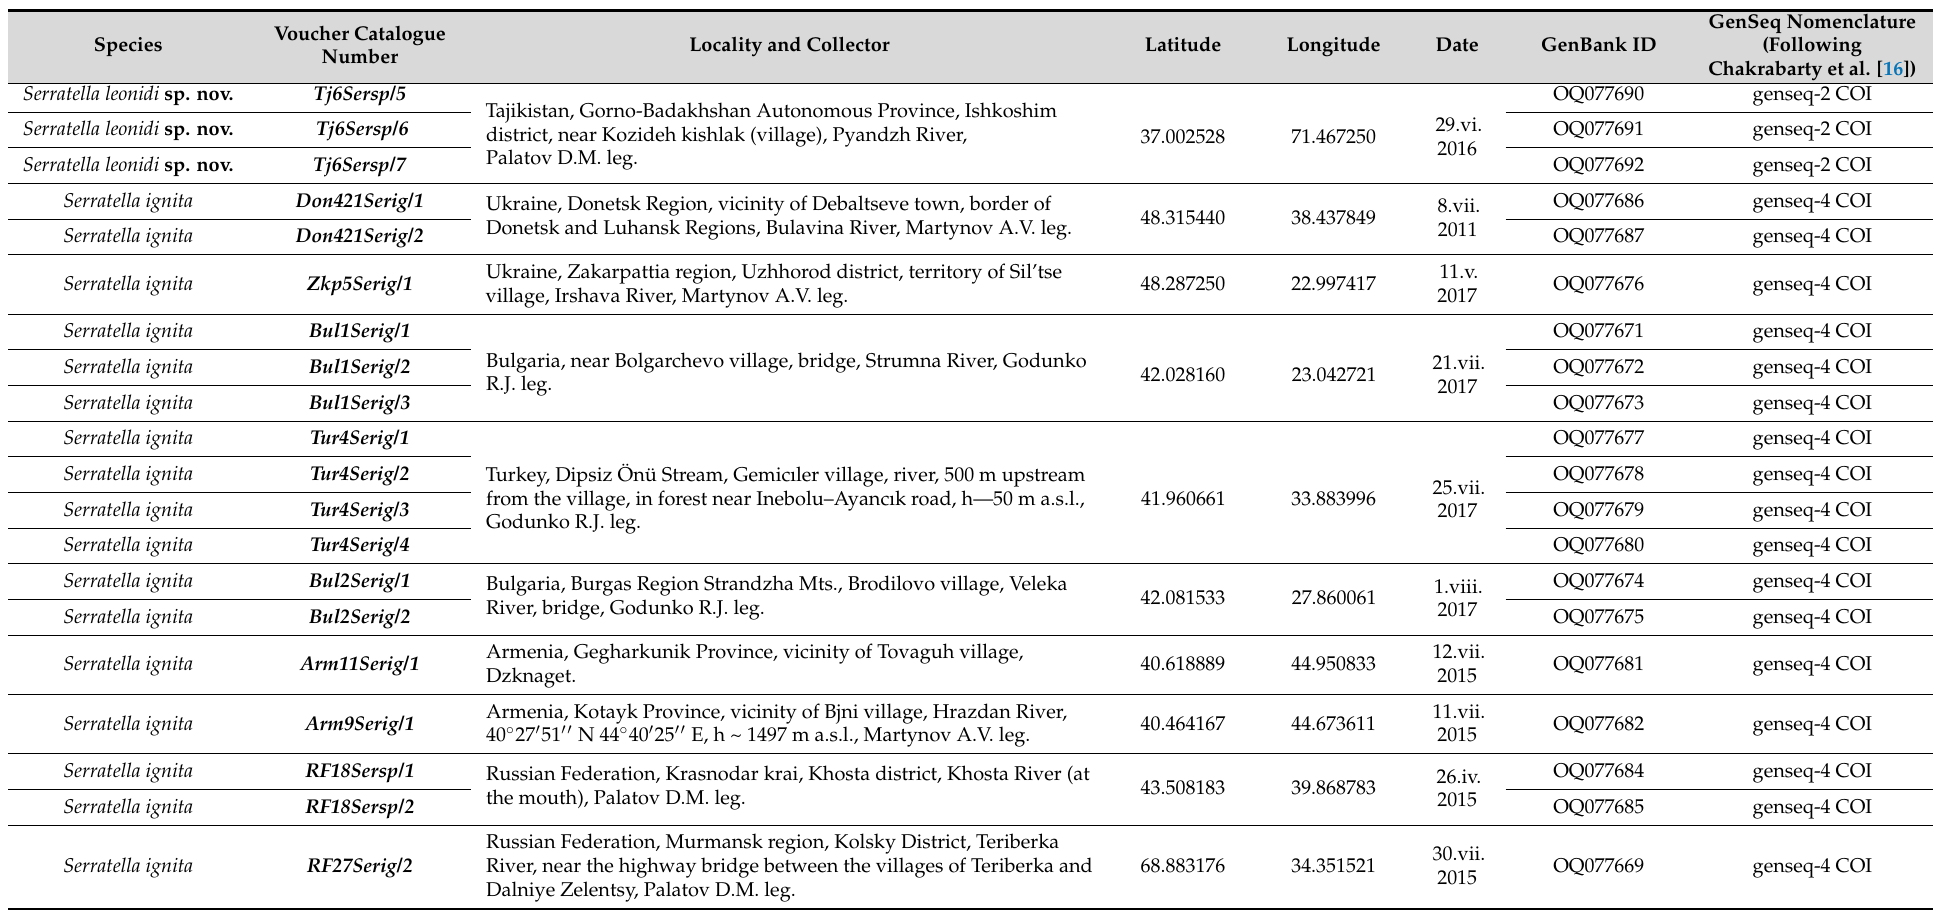
Table 1. Codes and origin of new sequences used in molecular